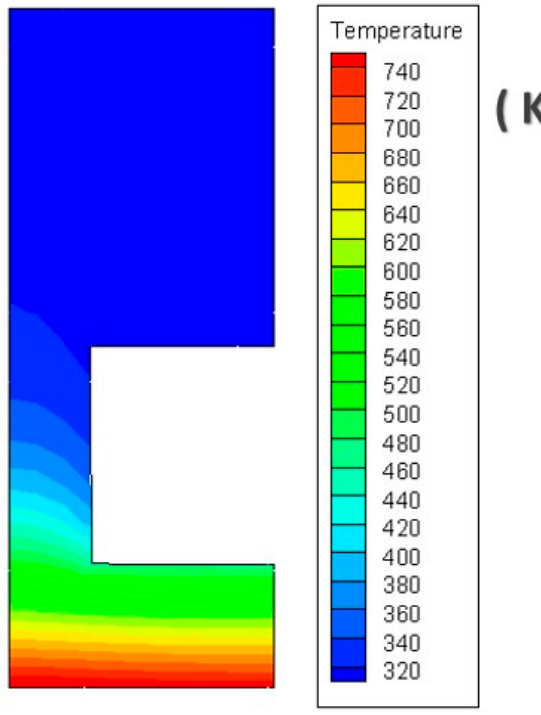
Figure 9. Temperature contour plot—Reference Model.